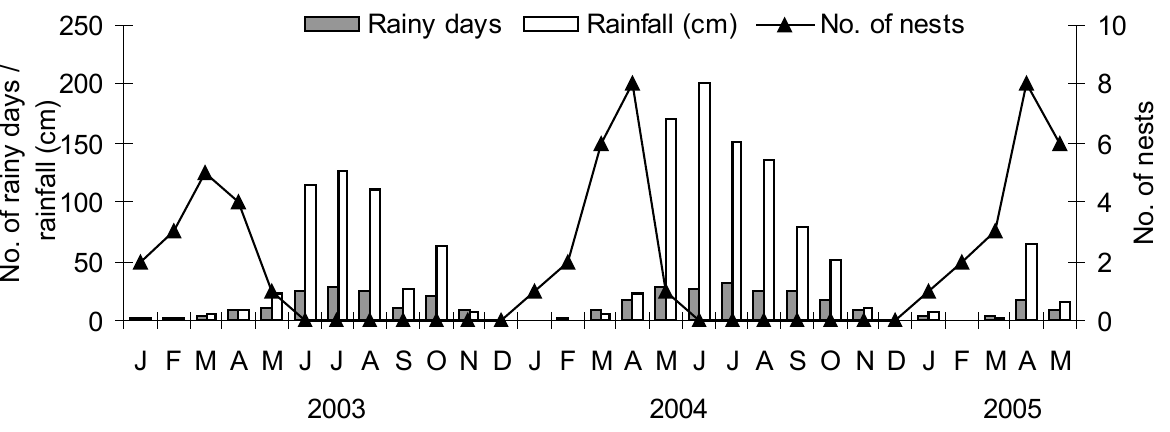
Figure 3. Relationship between clutch initiations of Grey-headed Bulbul with monthly rainfall and number of rainy days/ month at Silent Valley National